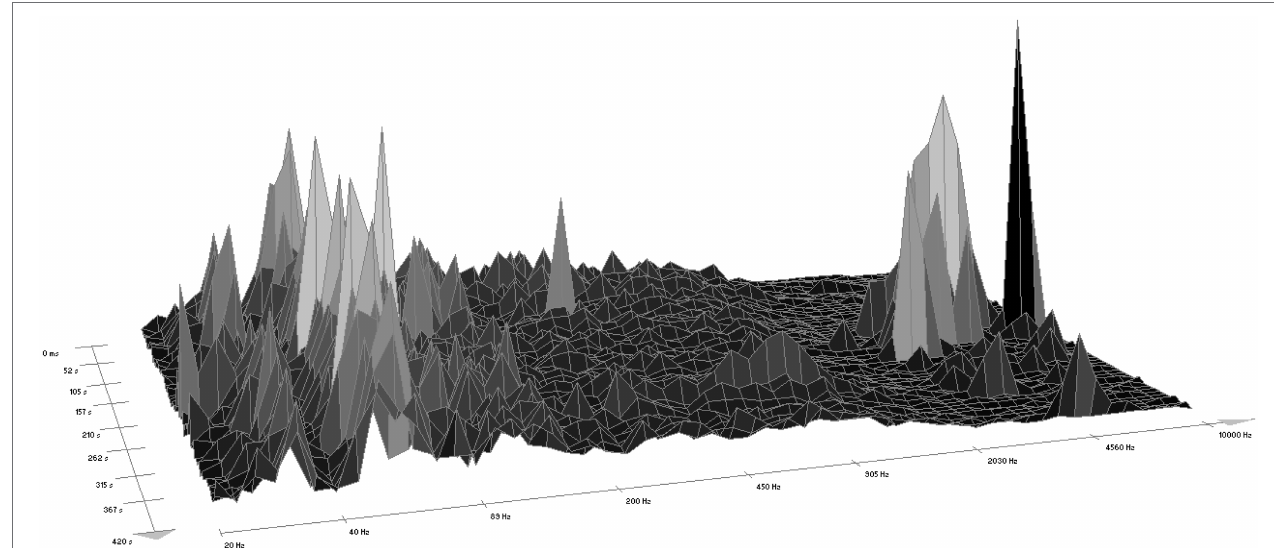
FIGURE 2 | A spectrogram of the sounds of a forest (according to WaveLab